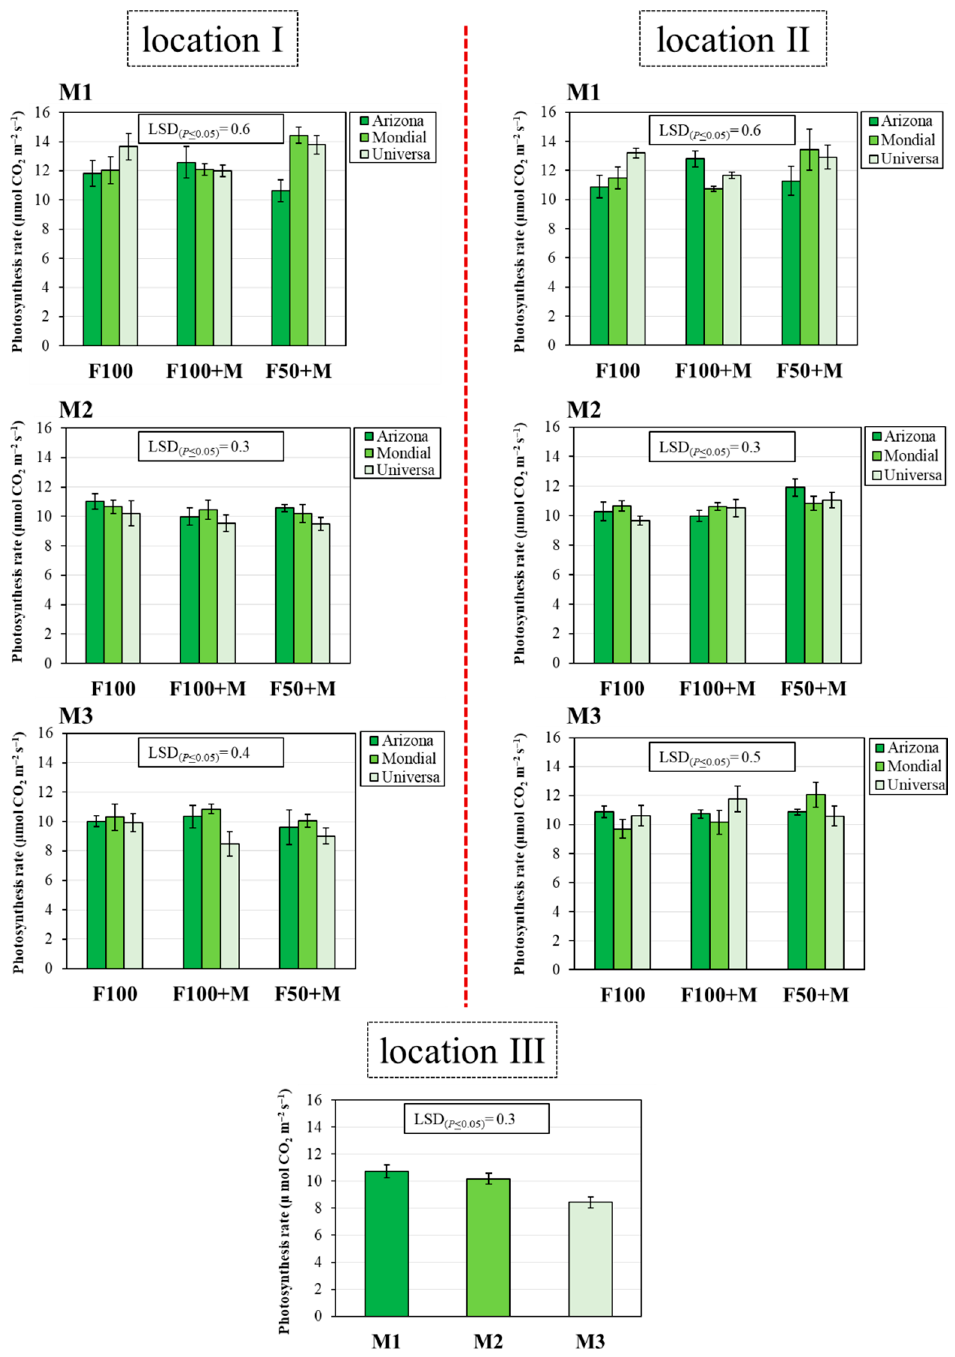
Figure 4. Photosynthetic rate ( µ mol CO 2 m − 2 s − 1 ) of leaves of early crop potato organically grown in highly calcareous soils as affected by fertilization management, soil type and potato cultivar. The Least Significant Difference (LSD) interaction was calculated with the Fisher’s protected LSD test at α = 0.05. Each bar indicates means ± standard deviation ( n = 5). F100: optimal fertilization without mycorrhizal inoculation (control); F100+M: optimal fertilization with mycorrhizal inoculation; F50+M: sub-optimal fertilization with mycorrhizal inoculation; ‘Arizona’, ‘Mondial’ and ‘Universa’: potato cultivars. M1, M2 and M3: first, second and third measurement date.